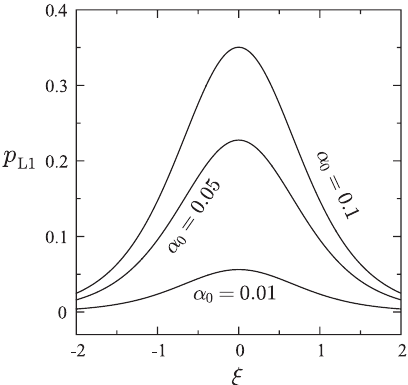
Fig. 3 Solitary wave profiles of the liquid pressure p L1 for | ξ | (cid:3) 2 given by Eq. (56). The initial void fraction α 0 is chosen as 0 . 1, 0 . 05, and 0 . 01, and the values of other physical quantities are the same as those used in Fig. 2. The height of soliton decreases with the decrease in α 0